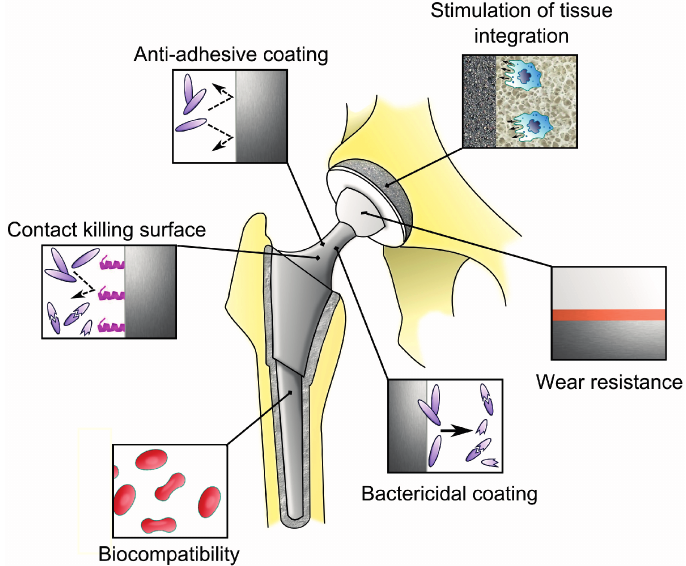
Figure 2. Ideas of multifunctional surfaces in total hip arthroplasty designed to simultaneously or successively respond to various biological and mechanical tasks. The response depends on the specific abilities of the coatings acquired during the manufacturing